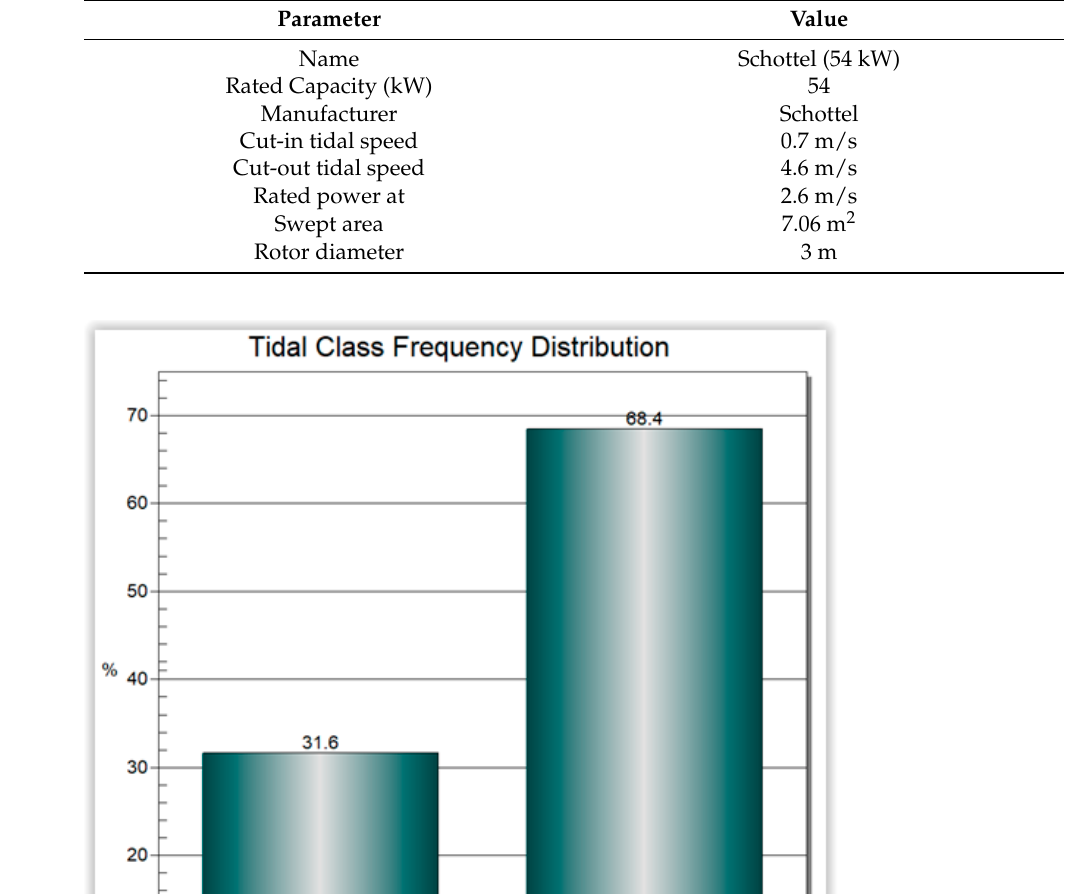
Table 4. Properties of generic 1 kWh lead–acid battery [20].